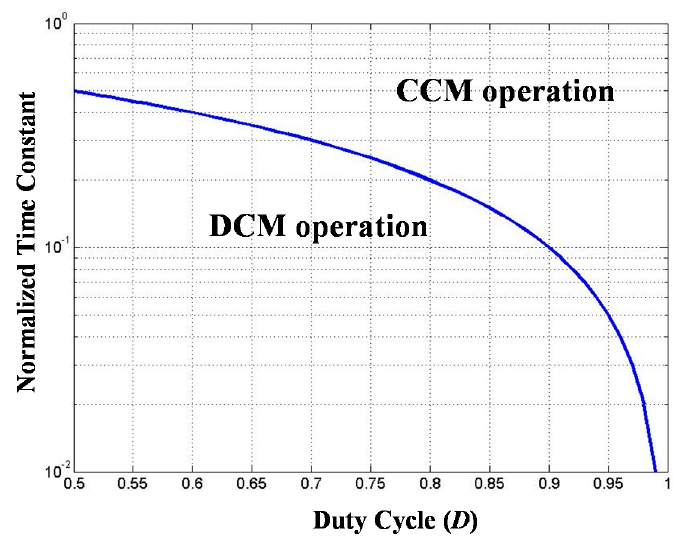
Figure 7. Normalized boundary inductance-time constant curve.